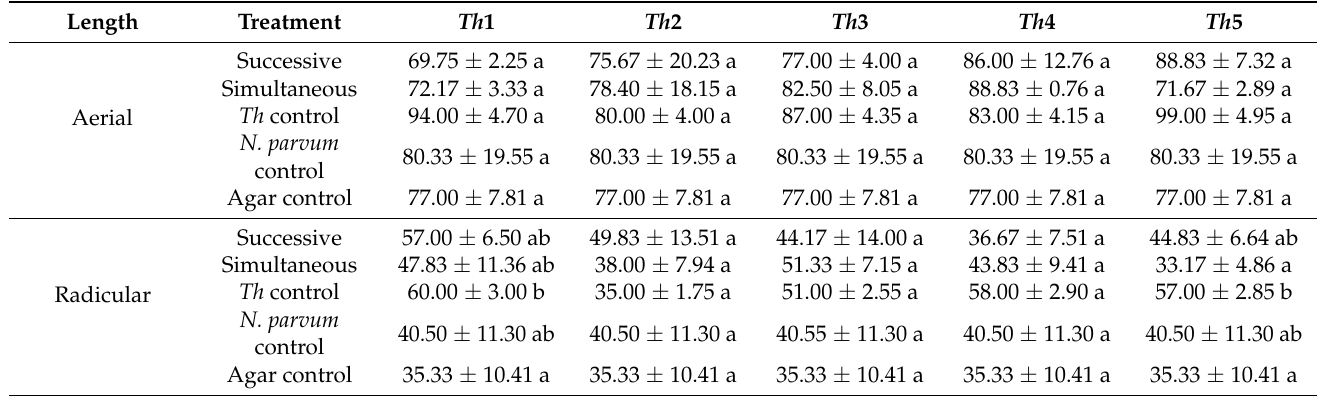
Table 4. Aerial and root biomass lengths of grafted plants in cm (mean ± standard deviation) for each type of treatment (successive or simultaneous inoculation with N. parvum and T. harzianum , and controls with plant inoculated only with agar) as a function of the T. harzianum isolate used.